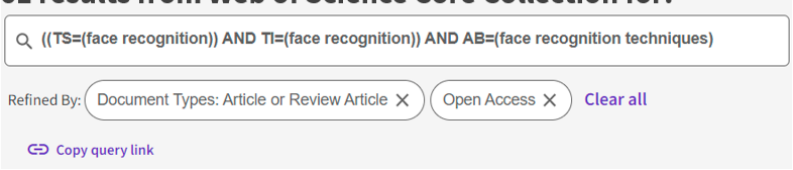
Figure 1. The keywords used on Web of Knowledge database platform.